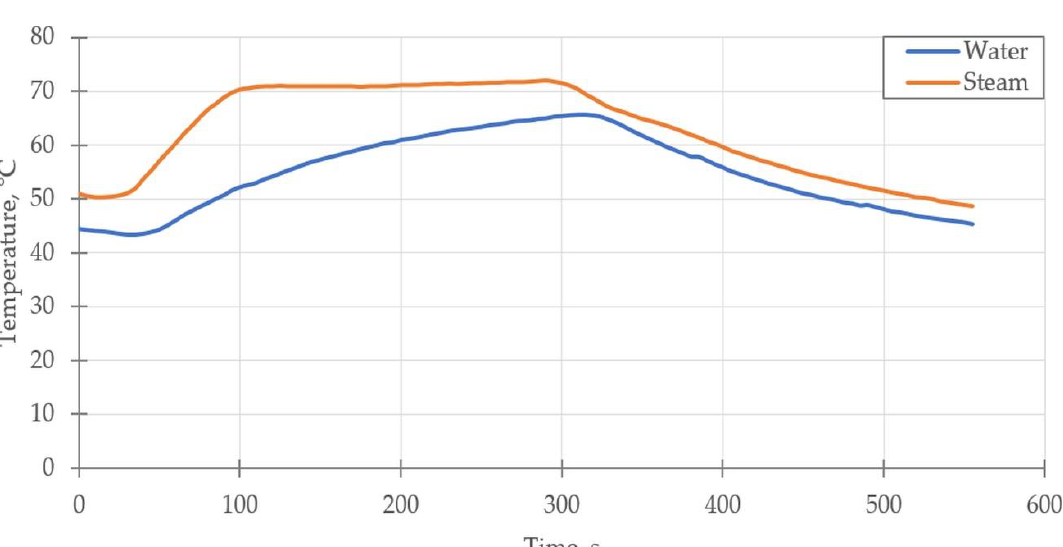
Figure 5. Pressure inside the bed (P3) during desorption.